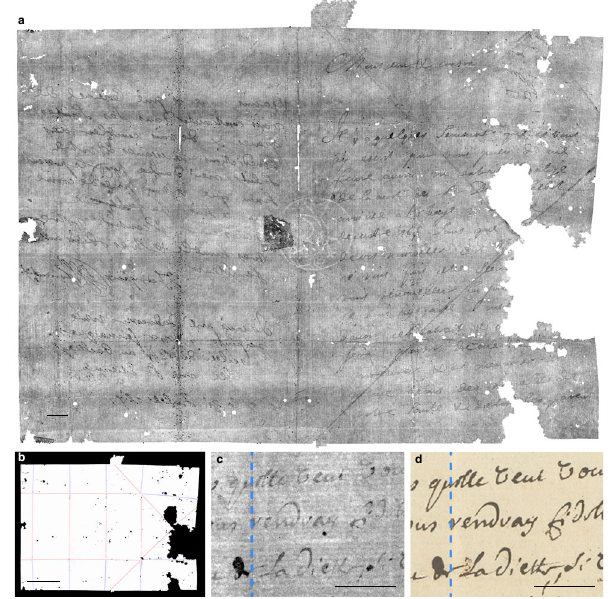
Fig. 6 Virtual unfolding results. Virtual unfolding results for unopened letter DB-1627 ( a , b ) and opened letter DB-2040, showing a XMT-textured image after virtual unfolding (this image has been inverted and linearly scaled to increase contrast of text and other details, such as a visible watermark in the center and laid and chain lines of the handmade paper); b crease pattern image; and c a close-up view of a portion of the fi nal texturing results for opened letter DB-2040 (inverted and linearly scaled), compared to d a photograph demonstrates low geometric distortion of the virtually fl attened result across a crease (indicated by the dashed blue line). Scale bars: a 10 mm, b 50 mm, c , d 10